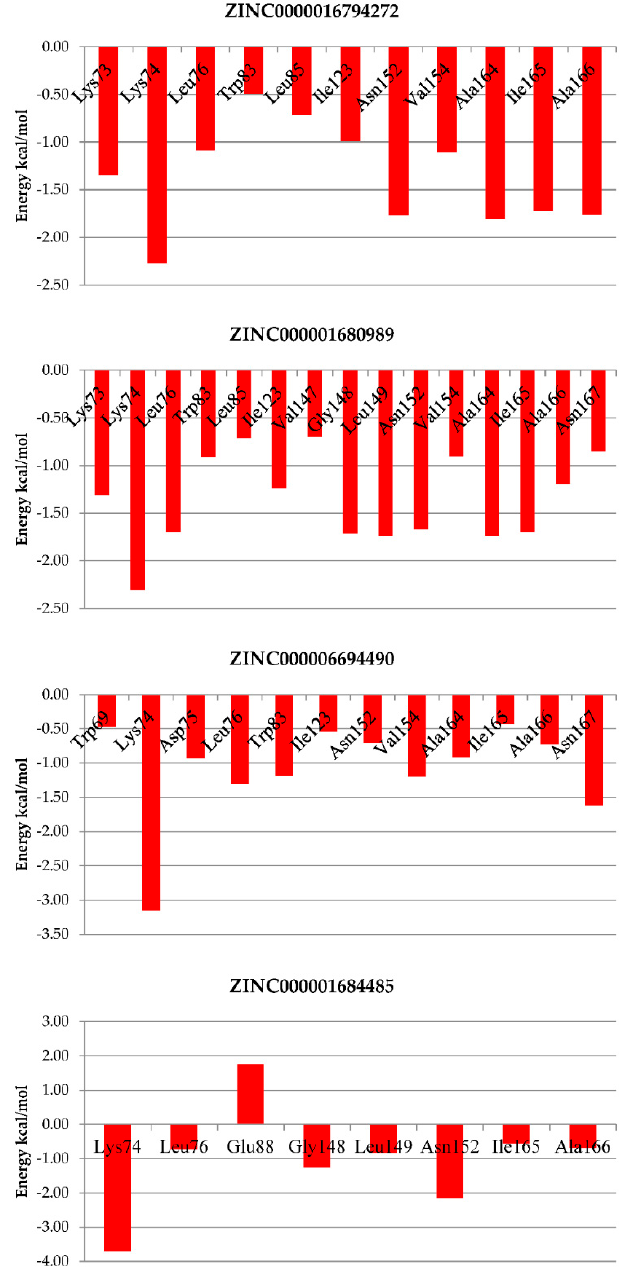
Figure 7. Graphical representation of the interaction energy per residue.